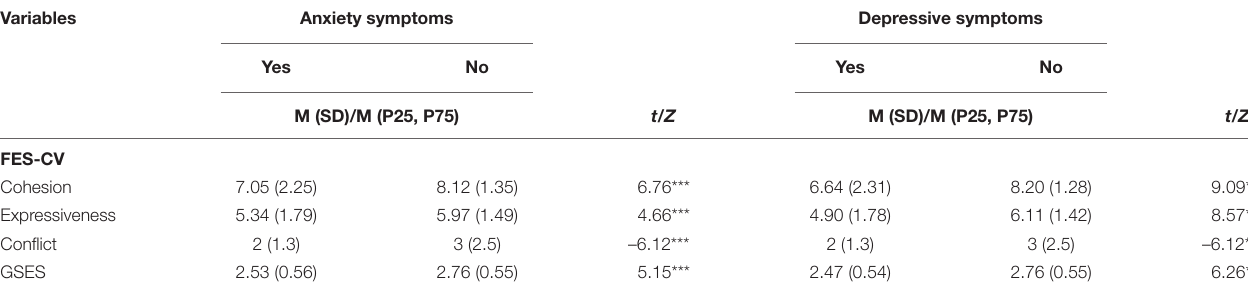
TABLE 2 | Differences in scores of the family environment and self-efficacy under different emotions ( N = 645). Variables